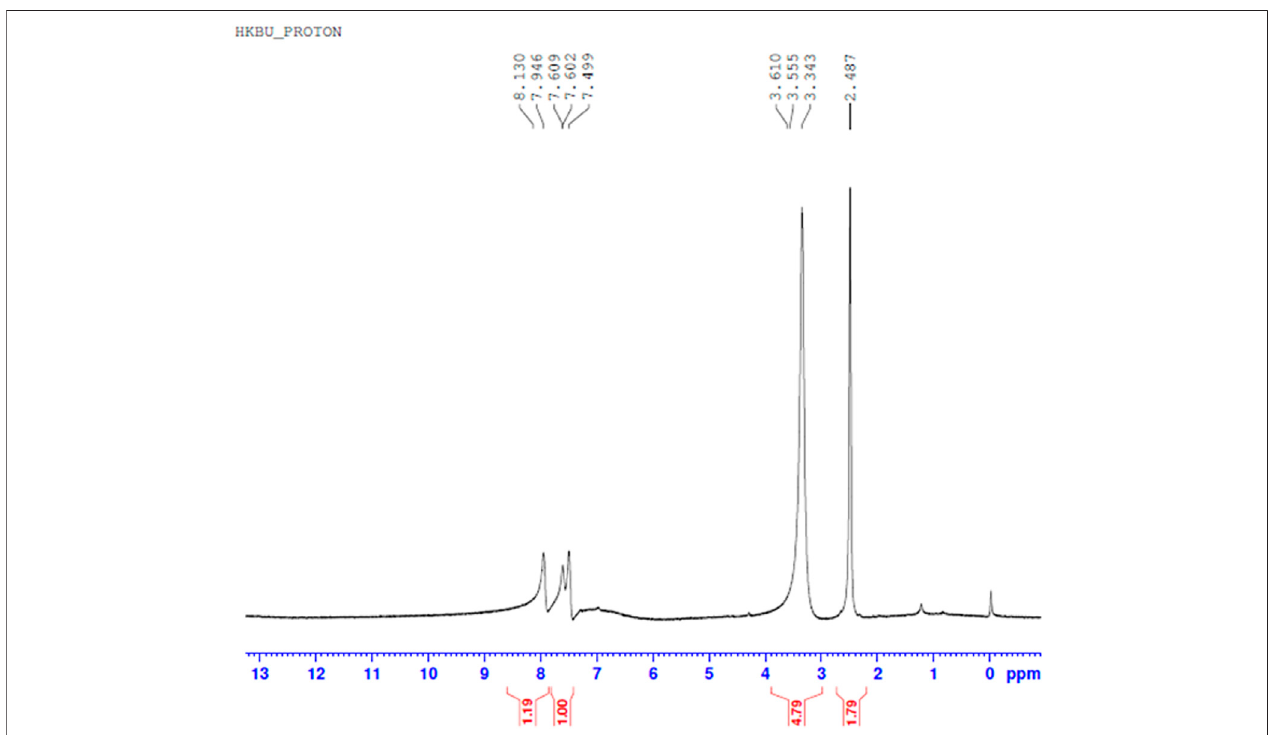
FIGURE 11 | 1 H NMR spectrum resulting from the addition of benzoic acid to chromium sulfate solution at 30 ° C to obtain precipitated product.